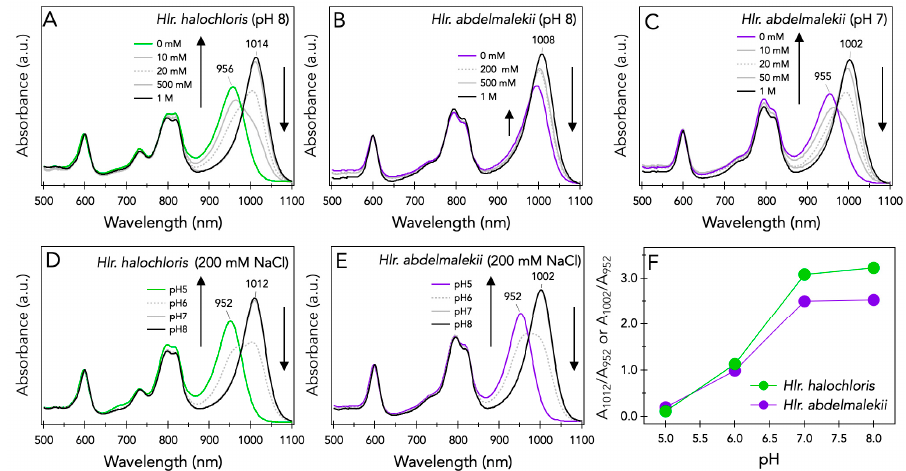
Figure 1. Absorption spectra of the LH1-RC complexes from Hlr. halochloris ( A , D ) and Hlr. abdelmalekii ( B , C , E ) at pH 8.5 in the presence of indicated concentration of NaCl at pH 8 ( A , B ) or pH 7 ( C ), and those at different pHs in the presence of 200 mM of NaCl ( D , E ). Panel ( F ) shows plots of the ratio of two LH1 Q y band intensities (A 1012 /A 952 for Hlr. halochloris and A 1002 /A 952 for Hlr. abdelmalekii ) at various pHs.